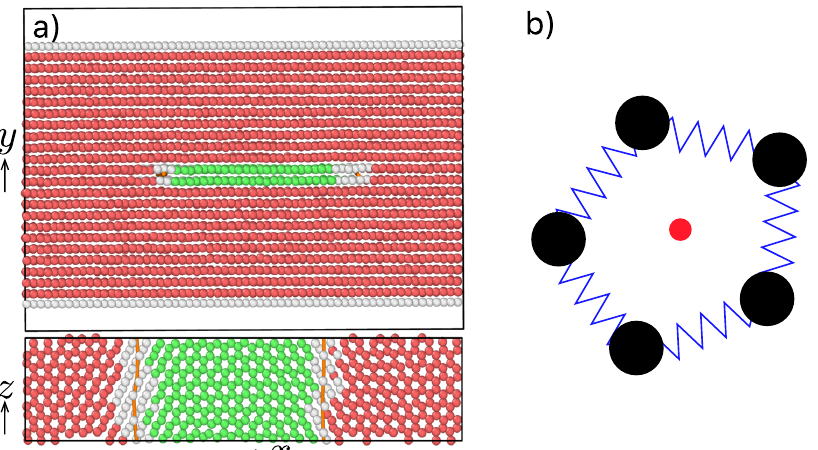
Fig. 1 Simulation cell geometry and centroid de fi nition. a Side and top view of simulation cell, with y -axis along the c -axis and x -axis along the ½ 1210 (cid:2) direction. Cell dimensions in the x , y and z directions are 117.4, 86.2 (including 17.4 Å of vacuum) and 25.4 Å , respectively. Colors of atoms are assigned according to the Common Neighbor Analysis approach 56 . Atoms depicted in red are in hcp surroundings, whereas atoms displayed in green are in an fcc environment and comprise the SF area separating the partials. White atoms indicate atoms in defective regions, either near partial dislocation cores or at free surfaces. Orange lines indicate partial cores. b Schematic representation of a closed atomic path in PIMC calculations, with black circles corresponding to system replicas for an example with M = 5. Central red circle depicts path ‘ center of mass ’ or